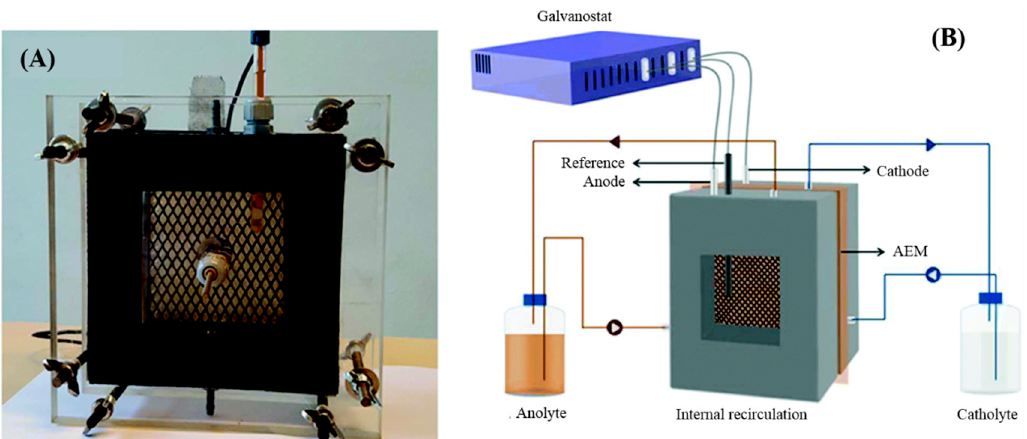
Figure 9. ( A ) Photo and ( B ) schematic illustration of the membrane electrochemical reactor [77]; published by Royal Society of Chemistry, 2018.